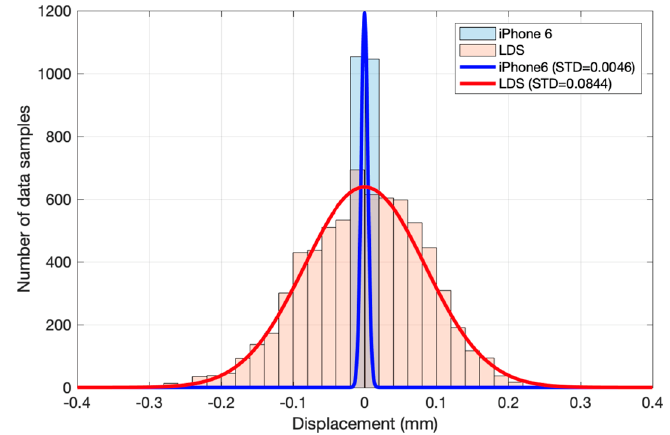
Figure 10. Error distribution of the 70-s data. (The continuous curves have been amplified many times.).